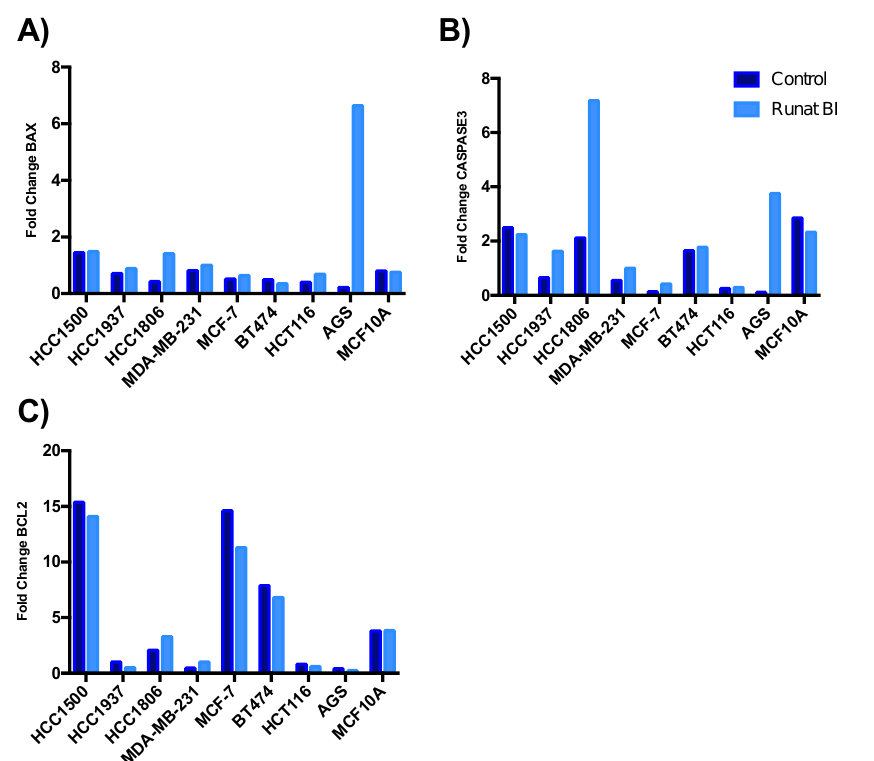
Figure 5. Expression of proapoptotic genes BAX ( A ), CASPASE-3 ( B ) and the antiapoptotic gene BCL-2 ( C ) in cancer cell lines after Runat-BI treatment. Fold-change (FC) results were obtained by quantitative RT-PCR for the BC lines HCC1500, HCC1937, HCC1806, MDA-MB-231, MCF-7, BT474; colon cancer line HCT116, gastric cancer line AGS and non-tumor line MCF10A. Dark blue represents control/PEG-treated samples and light blue represents Runat-BI-treated samples.